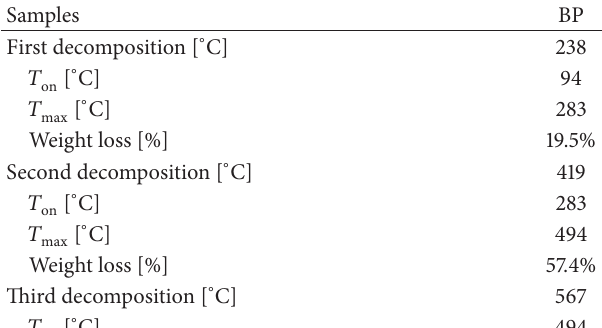
Table 2: The main injection moulding parameters used for LDPE/ SP